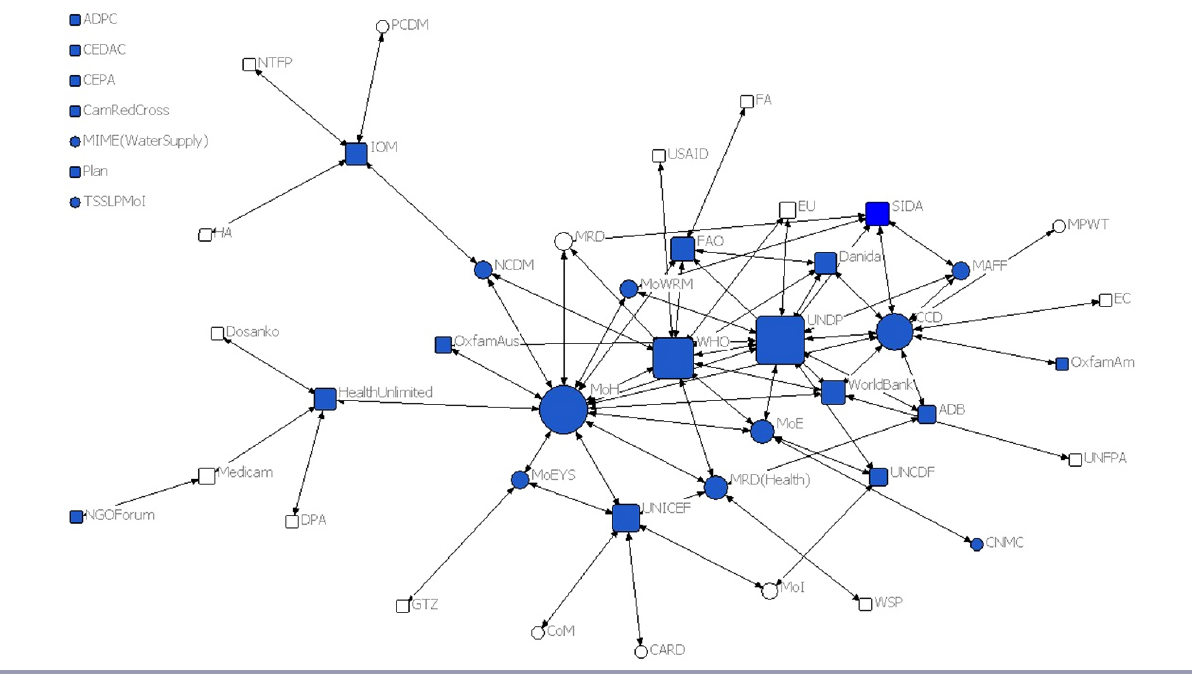
Fig. 2 . Health and climate change partnerships in